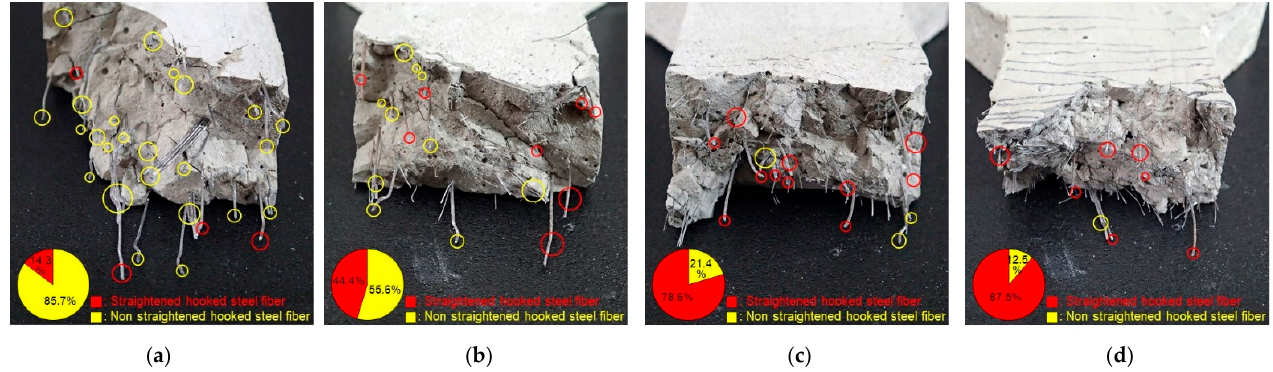
Figure 11. Fiber end-state of HSF in the fracture section after high-rate tensile test: ( a ) H2.0; ( b ) H1.5S0.5; ( c ) H1.0S1.0; ( d ) H0.5S1.5.